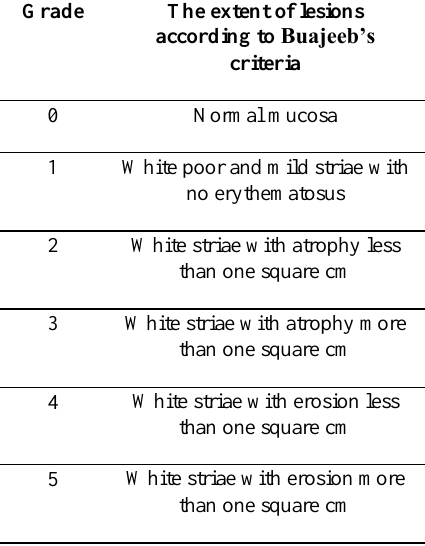
Table 1 . The extent of lesions from 0 to 5 according to Buajeeb’s